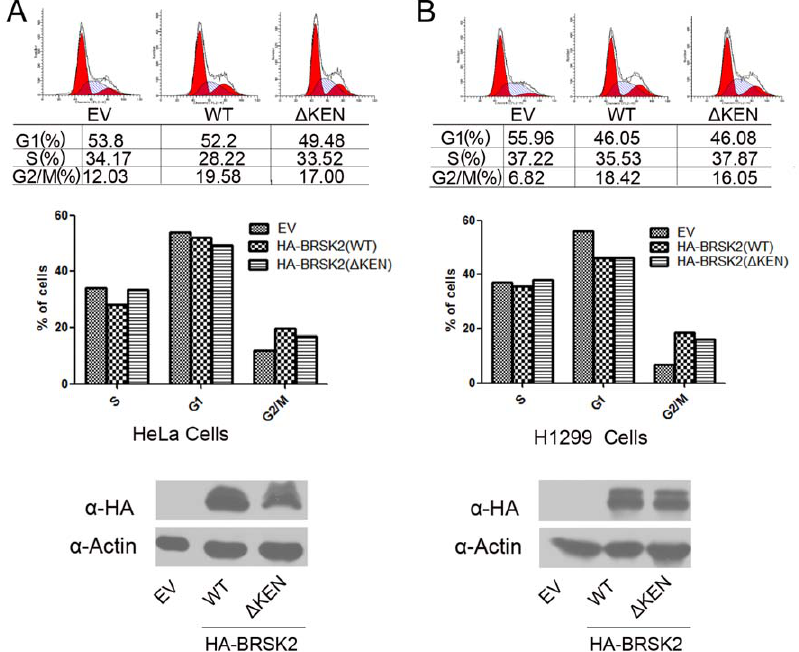
Figure 6. Over-expression of BRSK2 increases the population of cells in G2/M. Control, BRSK2(WT) or BRSK2( D KEN) plasmids were transfected with pBB14-GFP plasmid into HeLa cells and H1299 cells. Cells were harvested for flow cytometry analysis and Western blotting (WB) analysis using indicated antibody. The pBB14-GFP expression construct served as a positive transfection marker for flow cytometry analysis.